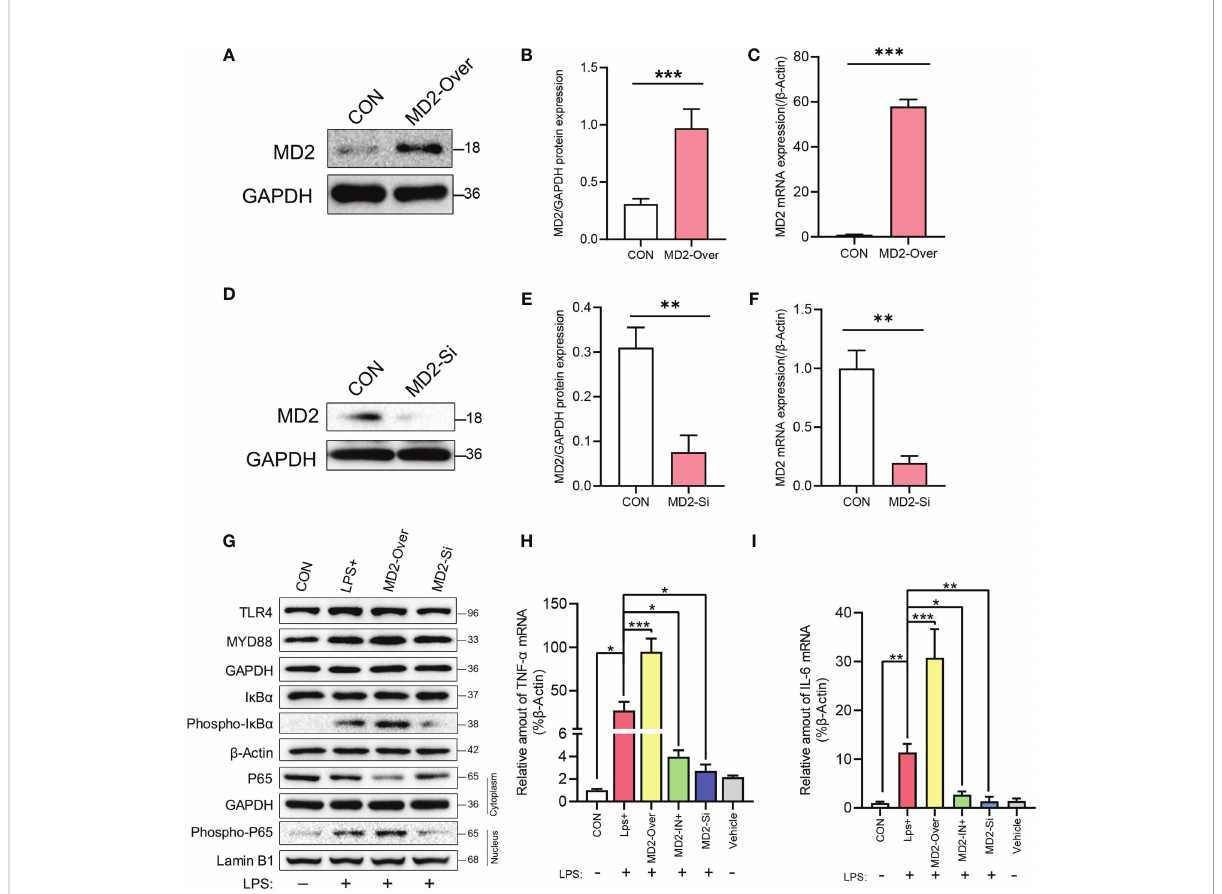
FIGURE 6 Ef fi ciency of MD2 overexpression or knockdown and the effects of LPS on NF- k B and the in fl ammatory response in IEC-6 enterocytes. (A – C) Evaluation of MD2 overexpression ef fi ciency by western blot analysis (n=4) and RT – qPCR analysis (n=3). (D – F) Evaluation of MD2 silencing ef fi ciency (n=3). (G) Effects of LPS on TLR4 signaling-related proteins, NF- k B activation and nuclear translocation of the p65 subunit of NF- k B in IEC-6 enterocytes (n=3). (H, I) The effect of LPS on proin fl ammatory cytokines in IEC-6 enterocytes was analyzed by RT – qPCR (n=3). LPS+, IEC-6 + LPS; MD2-Over, MD2-overexpressing IEC-6 + LPS; MD2-IN-1+, IEC-6 + MD2 inhibitor + LPS; MD2-Si, MD2-de fi cient IEC-6 + LPS; Vehicle, IEC-6 treated with DMSO at a 1:1000 dilution. (B – F) p value for each group comparison using a two-tailed Student ’ s t test. **p < 0.01, ***p < 0.001. (H, I) The p value was analyzed by one-way ANOVA with multiple comparisons, followed by Tukey ’ s post hoc test. *p <0.05, **p <0.01, ***p